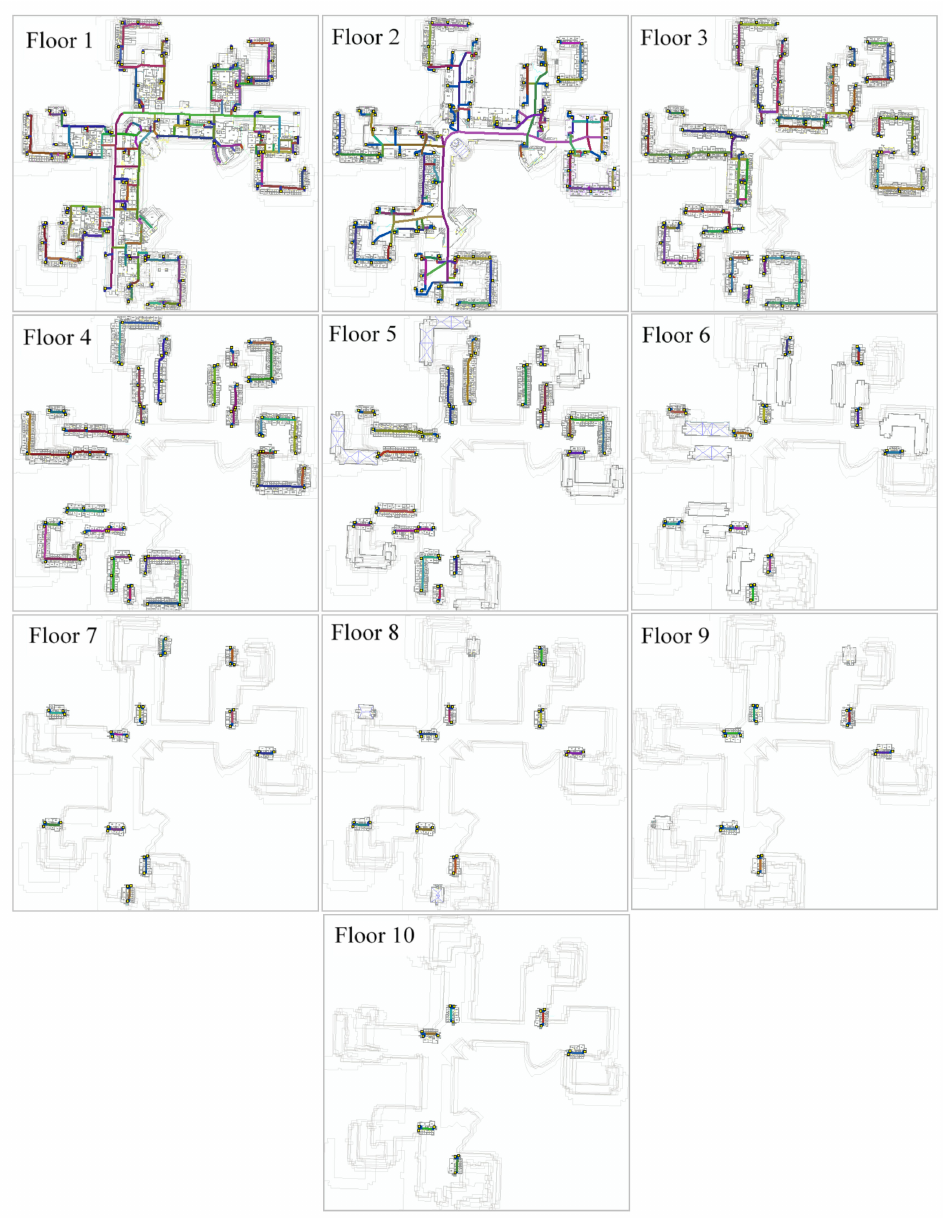
Figure 16. Strokes identified on each floor of the test